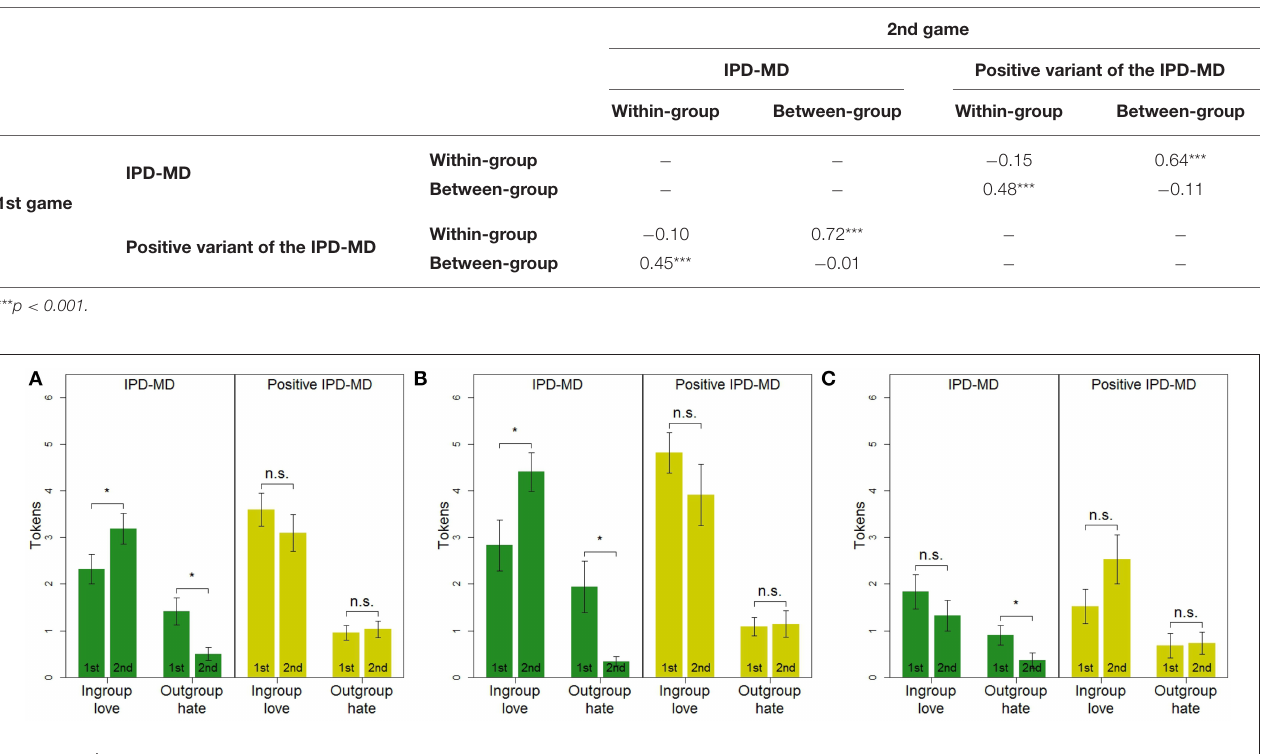
FIGURE 1 | Allocations to ingroup love and outgroup hate in the IPD-MD and Positive IPD-MD. (B,C) Are restricted to either pro-social or individualistic participants, respectively. Each pair of bars refers to conditions where the respective game was played first (left) or second (right). Ingroup love stands for the within-group account in the IPD-MD and for the between-group account in the positive variant of the IPD-MD; outgroup hate stands for the between-group account in the IPD-MD, and for the within-group account in the positive variant. * p < 0.05 ; Wilcoxon Rank Sum test. (A) All participants ( n = 144). (B) Pro-Social ( n = 79). (C) Individualistic ( n =